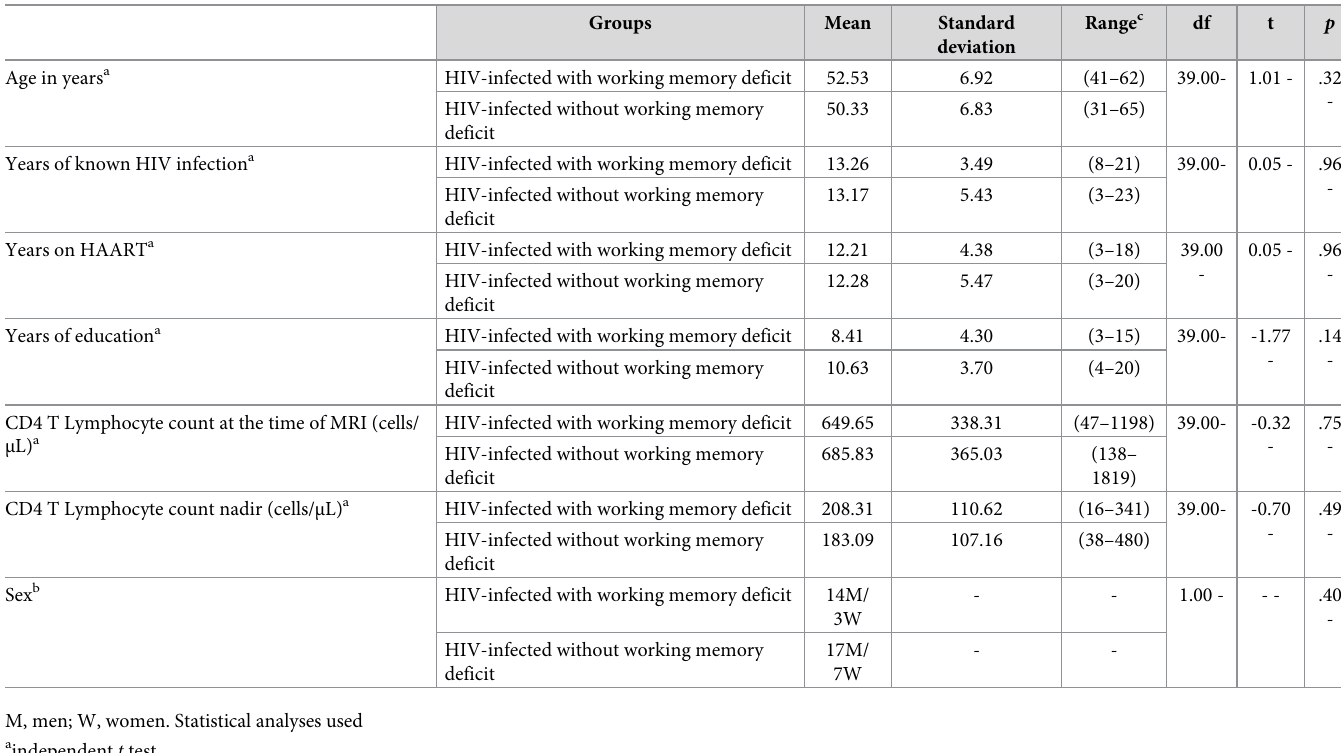
Table 1. Sociodemographic and clinical data of HIV-infected patients.